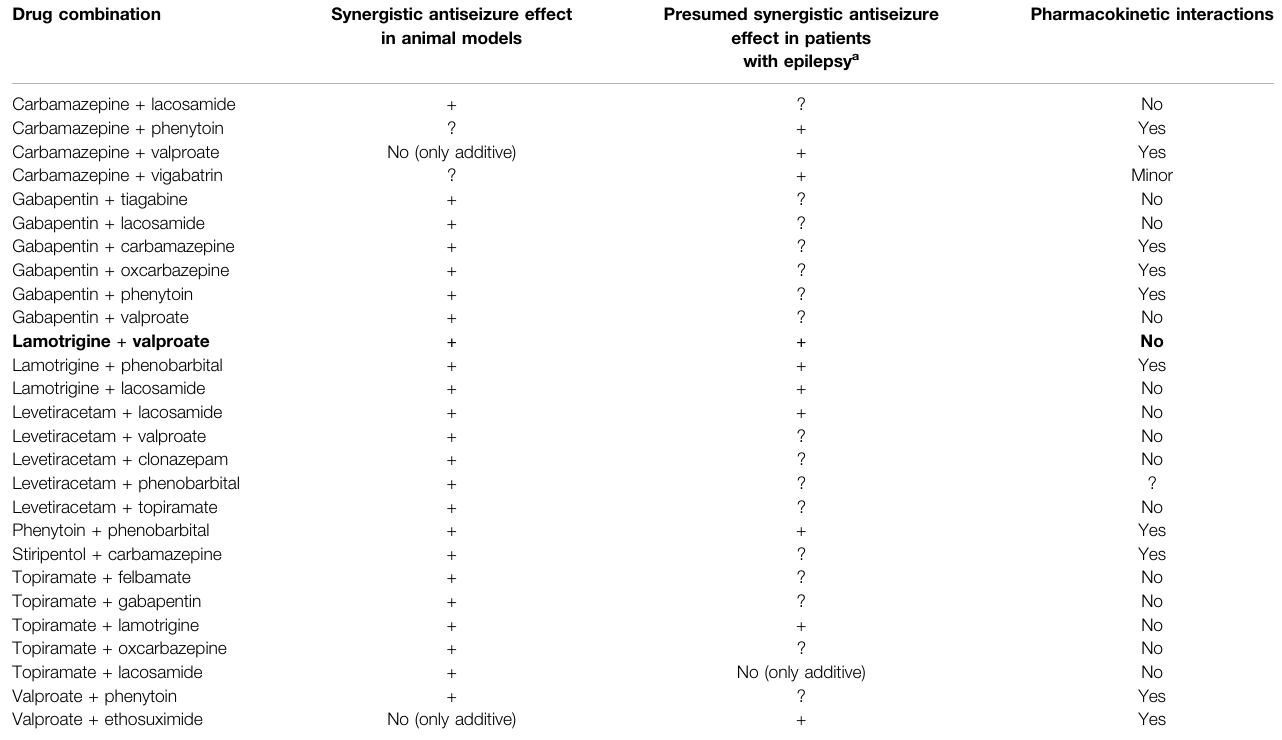
TABLE 3 | Experimental and clinical evidence for synergistic (supra-additive) two-drug combinations of antiseizure medications. For references see Deckers et al. (2000), Kaminskietal.(2009),Blaszczyketal.(2018),andVerrottietal.(2020a,b). “ ? ” indicatesthatnodatawerefound.Onlyfewdataareavailableonthecombinationsofmore than two antiseizure medications (not shown